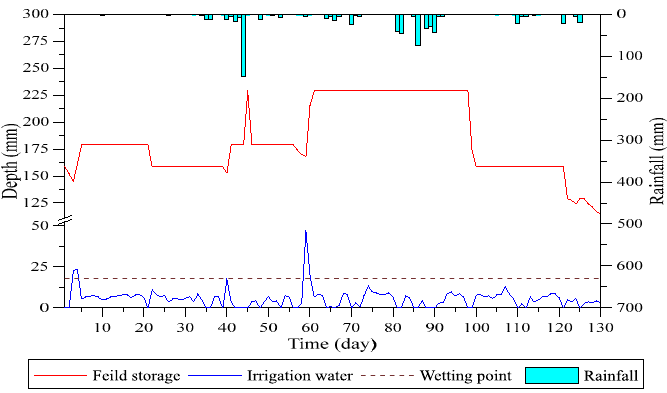
Figure 17. Simulation of block 3 under 30% reduction of planned irrigation water during the first crop Figure 17. season.